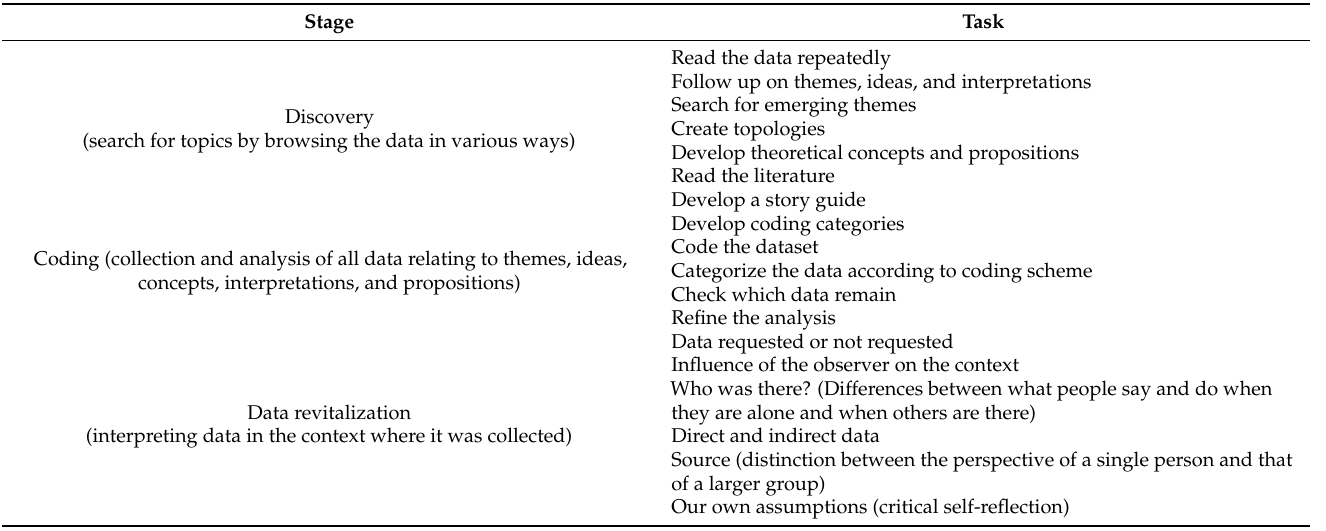
Table 2. Analytical process in qualitative research (Taylor-Bogdan).